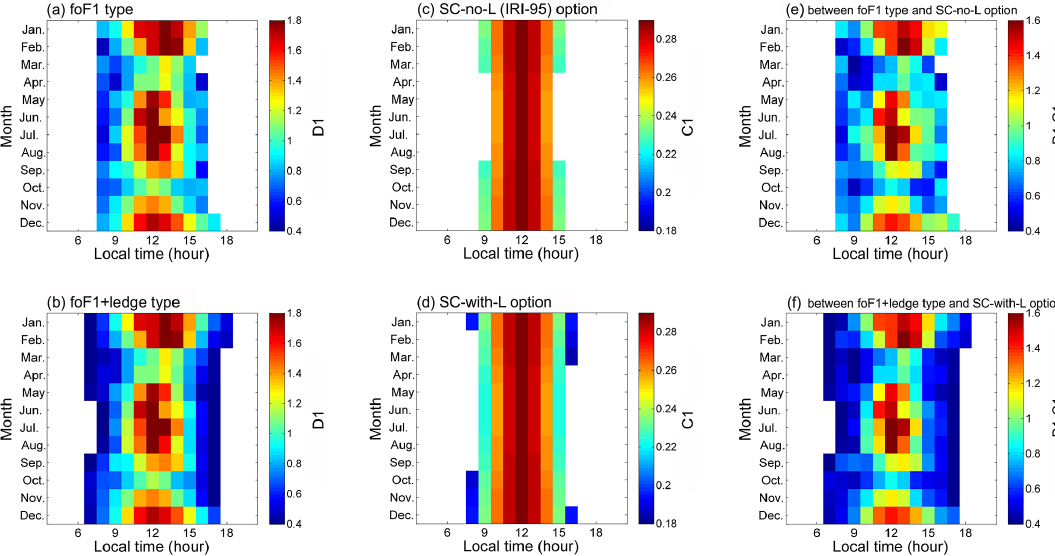
Figure 7. The monthly median D1 values for the (a) fo F1 and (b) fo F1 + ledge types of the Jicamarca digisonde, and the monthly median C1 values for (c) SC-no-L and (d) SC-with-L options of IRI-2012 during January–December 1996. The differences between D1 and C1 (c) for fo F1 type and SC-no-L option, and (d) for fo F1 + ledge type and SC-with-L option are